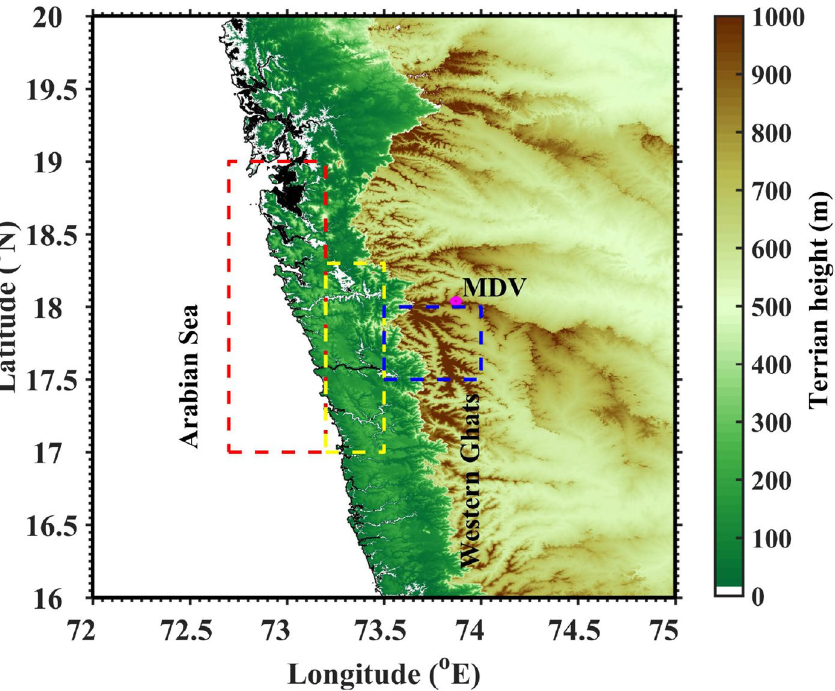
Figure 1. Topographical map of the study domain generated using the Shuttle Radar Topography Mission (SRTM) Version 3.0 Global 1 arc second data 60 (https:// earth data. nasa. gov/ learn/ artic les/ nasa- shutt le- radar- topog raphy- missi on- srtm- versi on-3- 0- global- 1- arc- second- data- relea sed- over- asia- and- austr alia). X-band radar location, Mandhardev (MDV), is shown with a solid magenta circle. The coastal, windward and high altitude regions are shown with red, yellow, and blue dashed rectangles, respectively. The topographical map is generated using MATLAB R2019b programming